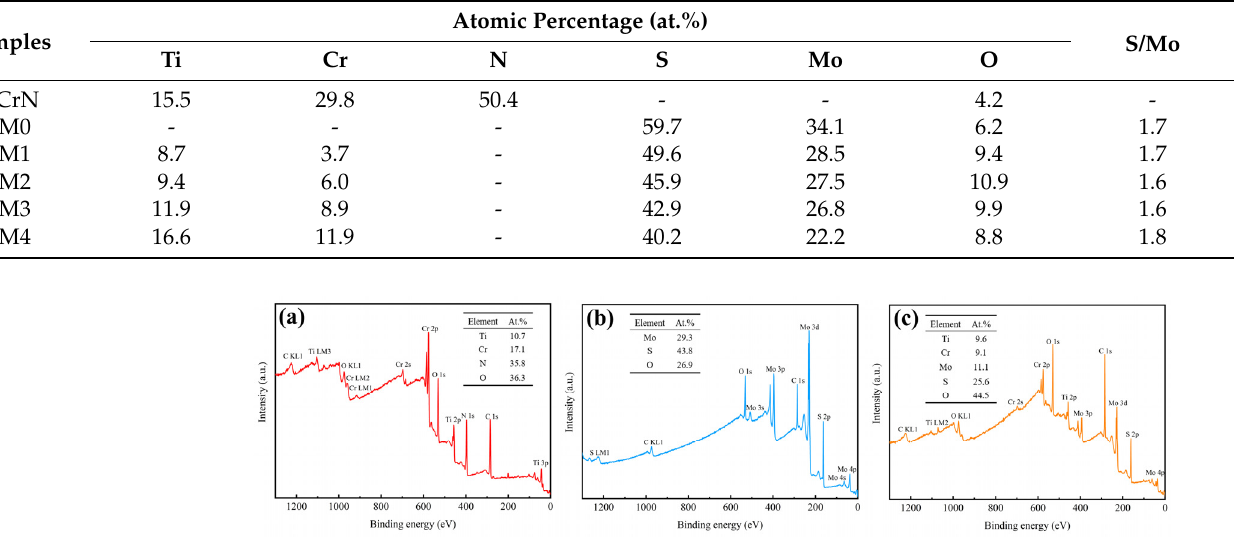
Figure 2. XPS survey spectra of ( a ) TiCrN, ( b ) TM0, and ( c ) TM3 coatings.